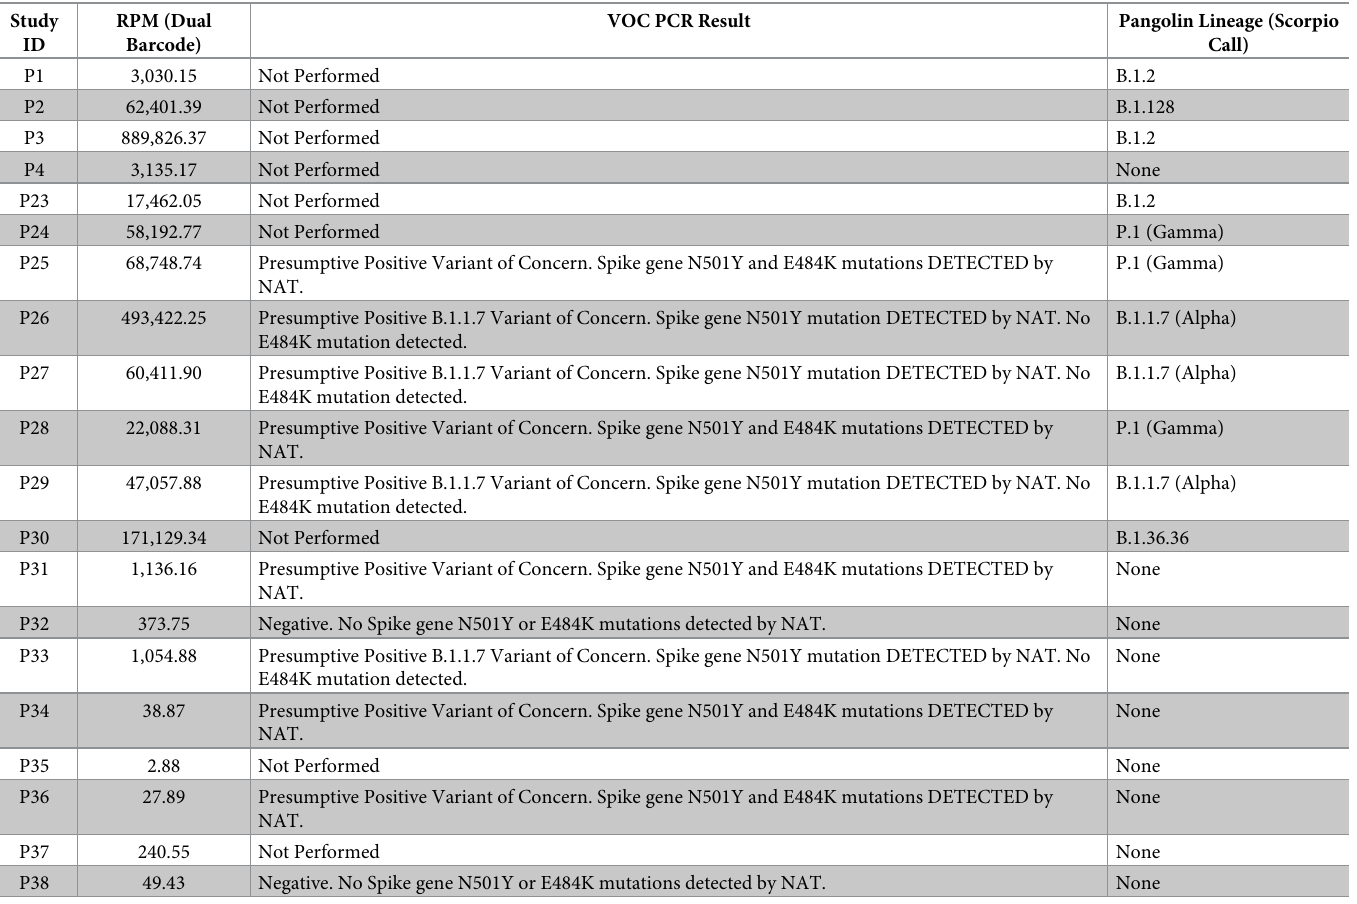
Table 5. SARS-CoV-2 variant of concern PCR and Pangolin classification